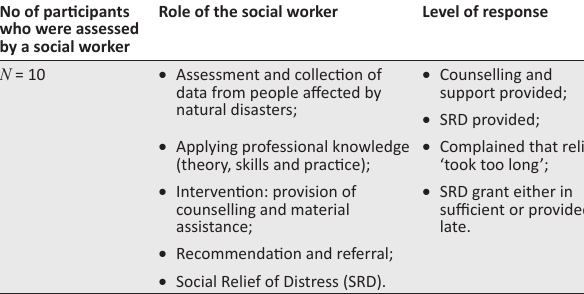
TABLE 2: Social workers assessments.